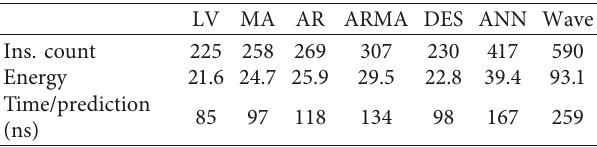
Table 3: Per prediction processing requirements and energy consumption of predictors in μ J.